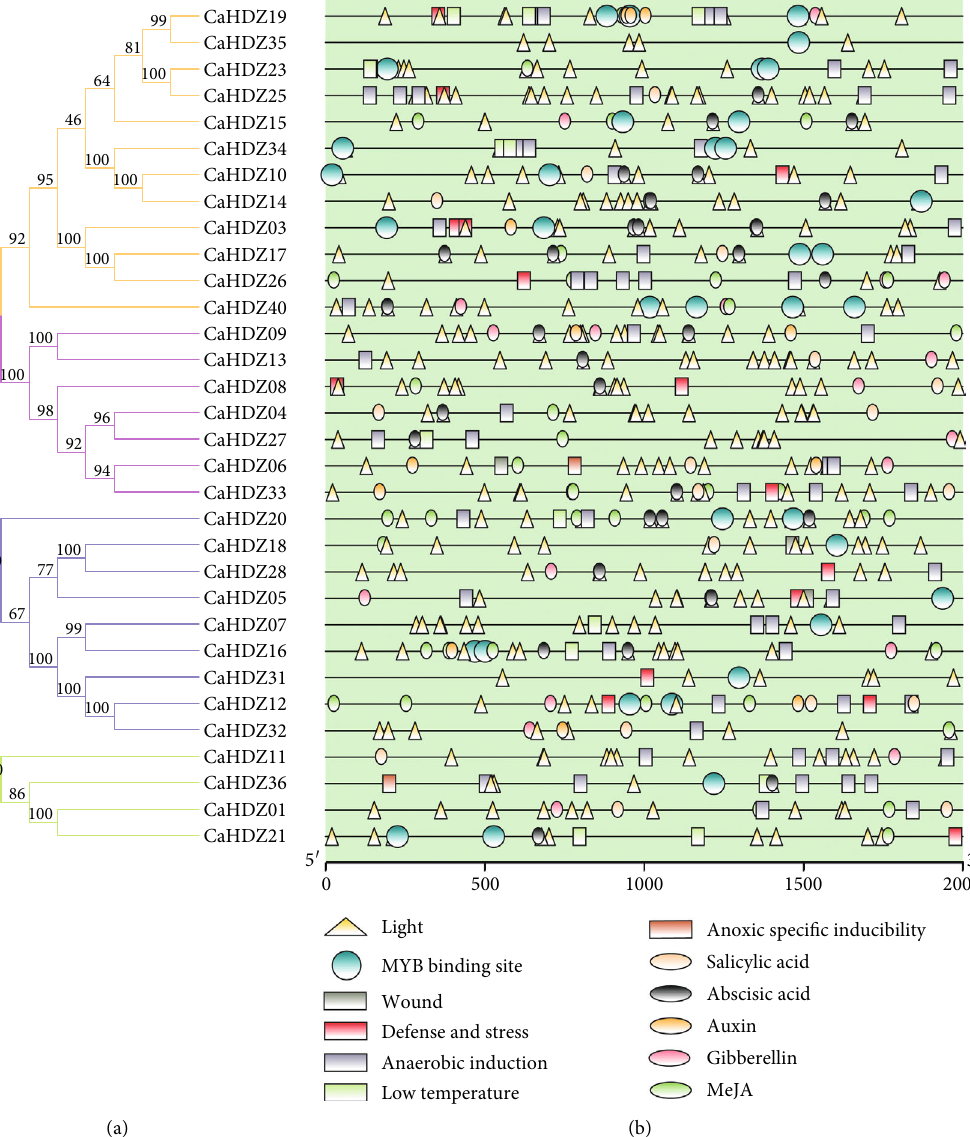
Figure 3: Cis analysis of CaHD-ZIP promoter related to stress response. Di ff erent cis-elements with the same or similar functions are shown in the same shape and